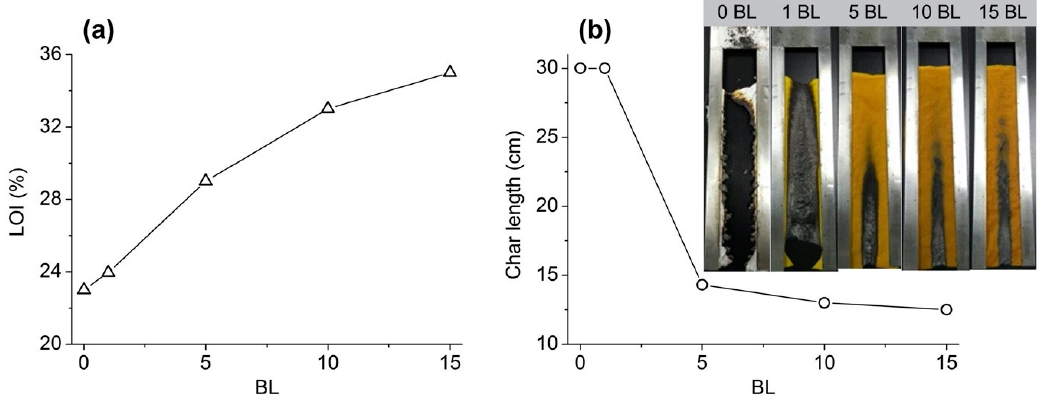
Figure 14. Results from LOI ( a ) and flame spread tests ( b ) for untreated and LbL-treated silk fabrics. Reprinted with permission from [43]. Copyright 2019, Elsevier.